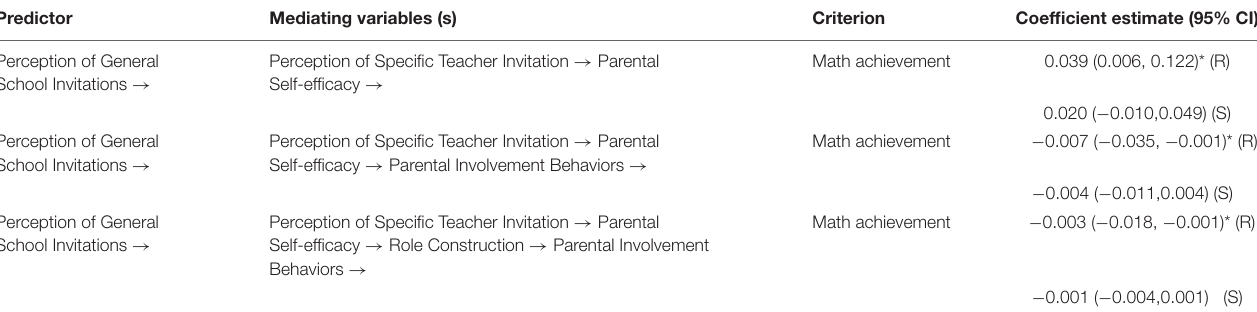
TABLE 3 | Raw (R) and standardized (S) coefficients of indirect effect estimates of parents’ perceptions of general school invitations on children’s math